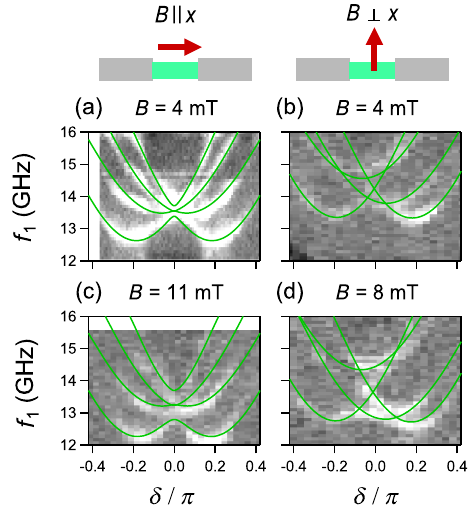
FIG. 6. Effect of an in-plane magnetic field on the ABS excitation spectrum around δ ¼ 0 . The Andreev states correspond to the same gate voltage as in Fig. 5. Field is applied parallel [(a), (c)] or perpendicular [(b),(d)] to the wire. Green lines are the result from the theory using g ⊥ ¼ 12 and g k ¼ 8 (see